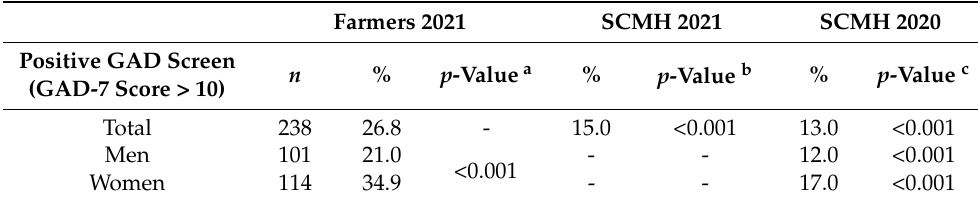
Table 4. Prevalence of positive GAD screen (GAD-7 score >10) for the overall 2021 sample and by gender, and in comparison to Canadian general population from Statistics Canada’s Survey of COVID-19 and Mental Health (SCMH) cycles 1 (Spring 2020) and 2 (Fall 2021) [57].